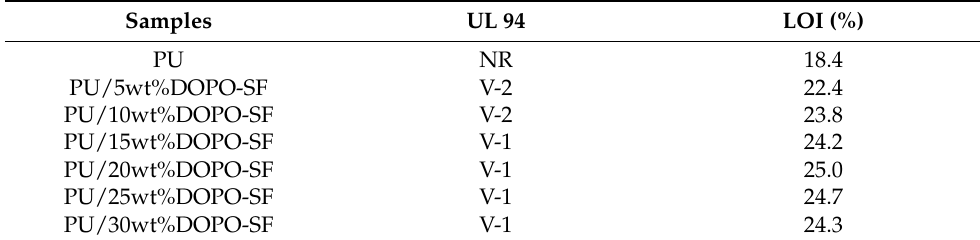
Table 5. LOI values and UL 94 ratings of flame-retardant PU by